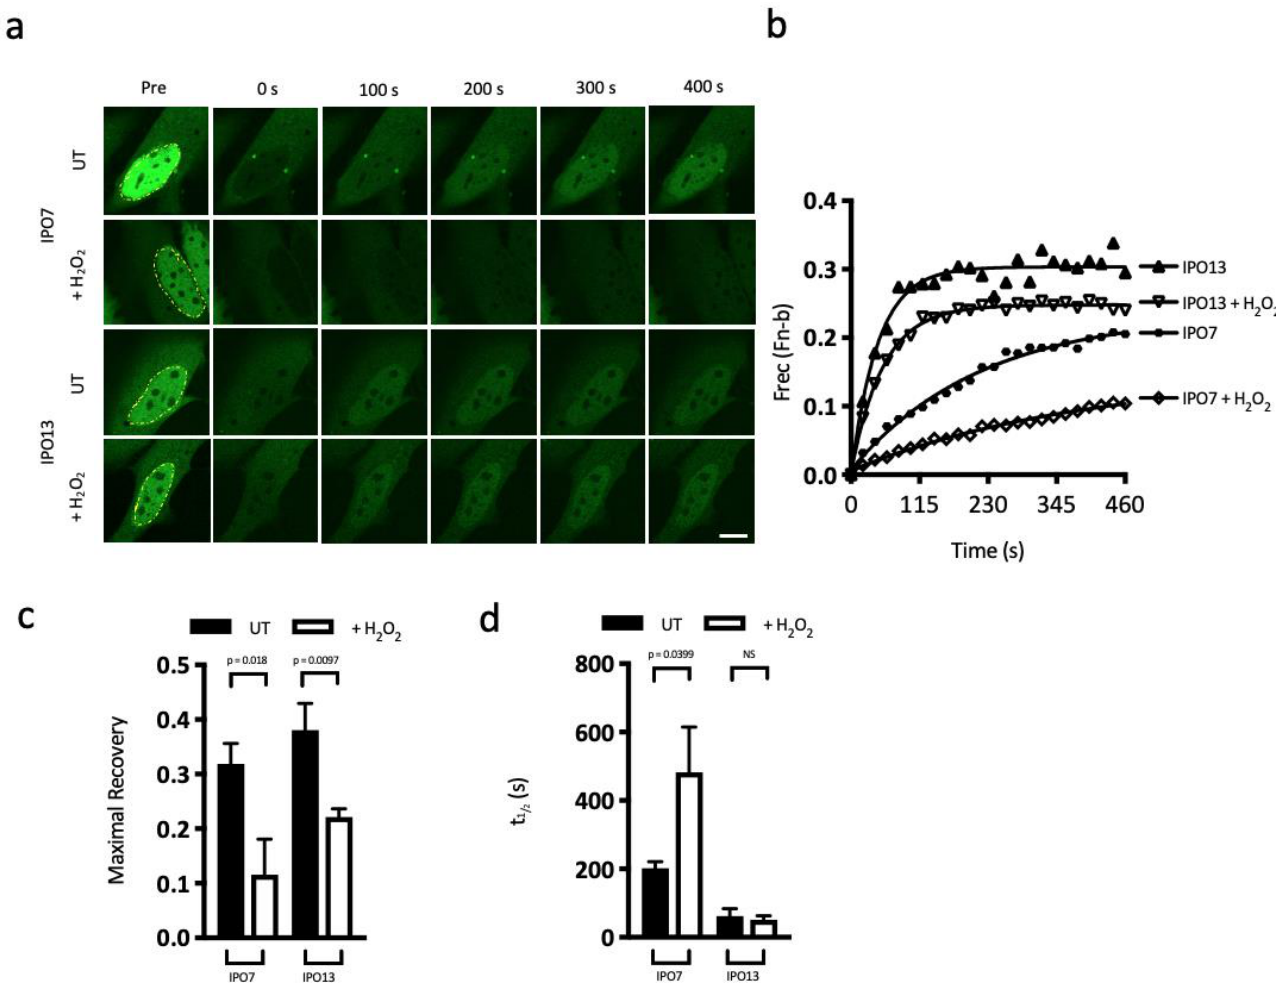
Figure 6. IPO13, unlike IPO7, continues to traffic into the nucleus under H 2 O 2 -induced oxidative stress. ( a ) CLSM images of HeLa cells transfected to express GFP-IPO7 or GFP-IPO13 and treated ± 125 μM H 2 O 2 for 1 h. Cells were imaged prior to photobleaching (Pre) in the indicated nuclear region (dotted outline in yellow) and then monitored every 20 s for 8 min. ( b ) Digitised images, such as those in ( a) were analysed to determine the fractional recovery of nuclear fluorescence (Frec(Fn-b)), Scale bar = 10 μM. Results shown are for a single representative cell under each condition. Curves , such as those generated in ( b ), were used to determine the maximal recovery of nuclear fluorescence ( c ) and the time post-bleaching to reach half-maximal recovery (t 1/2 ). ( d ) Results represent the mean ± SEM (n = 20); typical results from 2 separate experiments. p -values indicate statistical differences as determined by Student ’ s t -test.